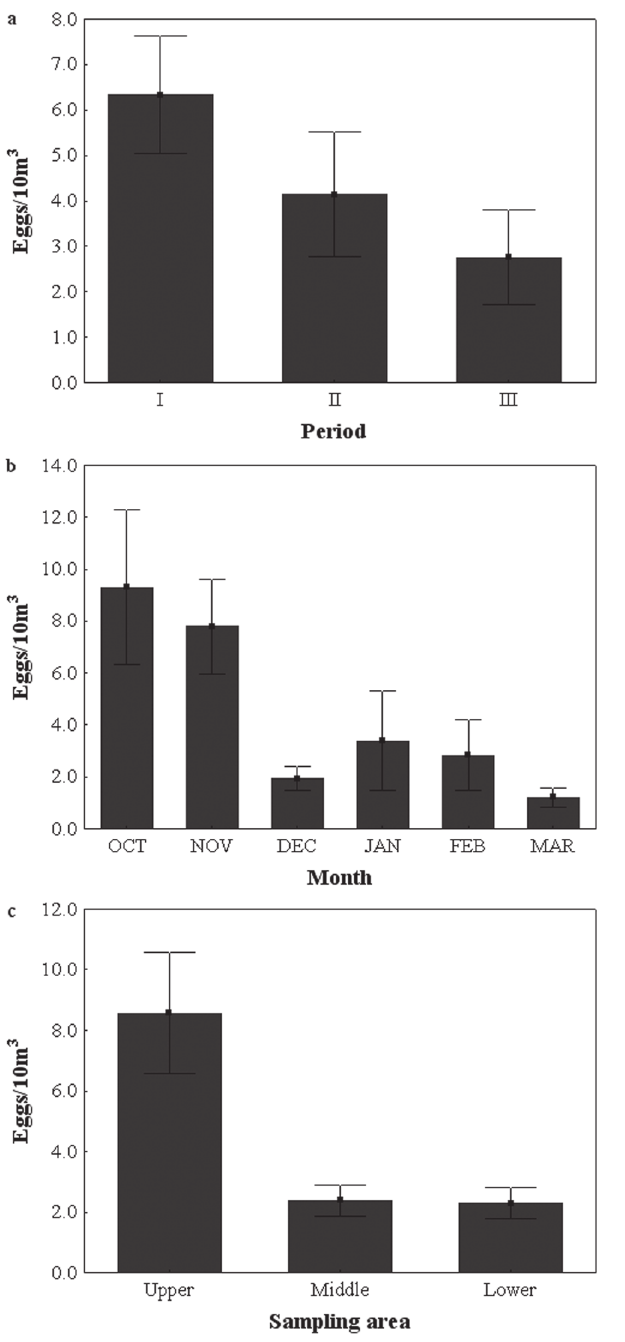
Fig. 3. Average fish larval abundances (rectangles) and standard errors (bars) by period ( a ), month ( b ) and sampling area ( c) in the Ilha Grande National Park, from October 2001 to March